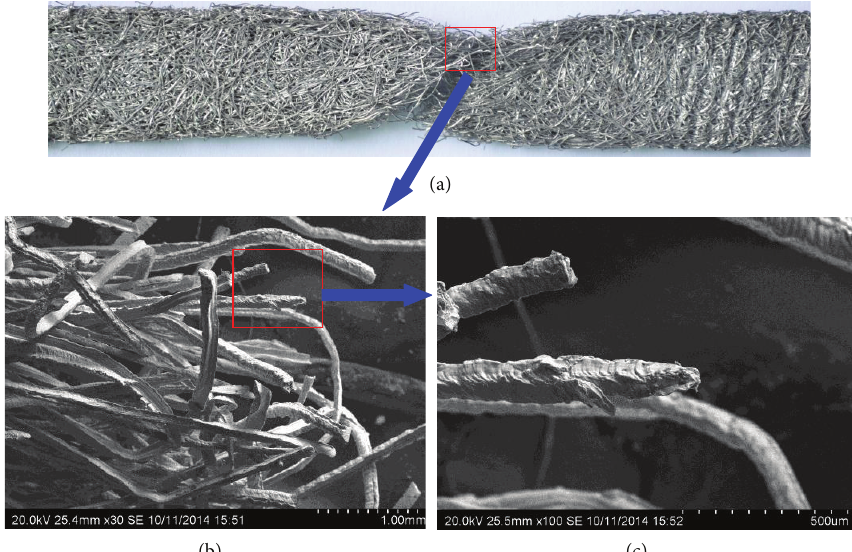
Figure 10: Failed sample with 80% porosity sintered at 1100 ∘ C for 60 min. (a) Fracture appearance, (b) SEM image of fracture region, and (c) fractured fiber with necking